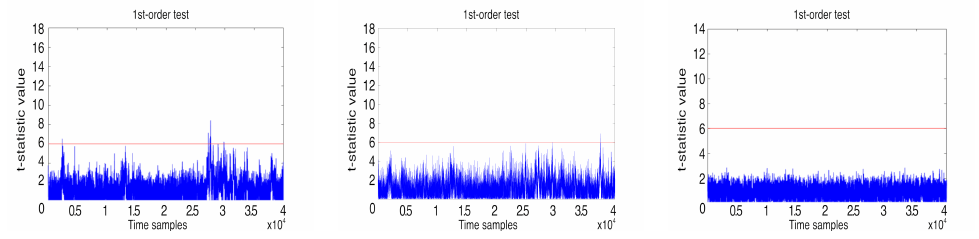
Figure 22: rdm vs fixed Figure 23: rdm vs fixed Figure 24: rdm vs fixed scalar